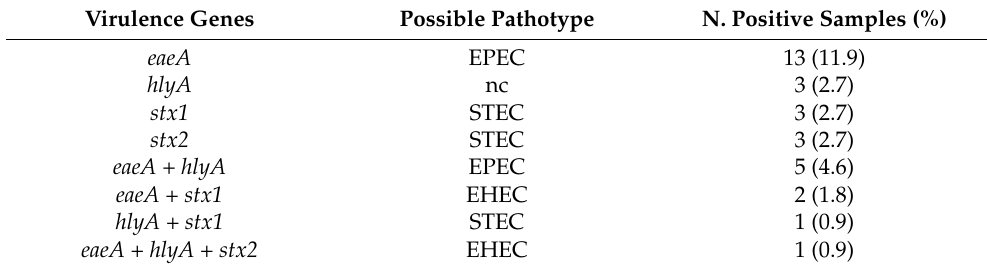
Table 2. DNA samples resulted positive for one or more virulence